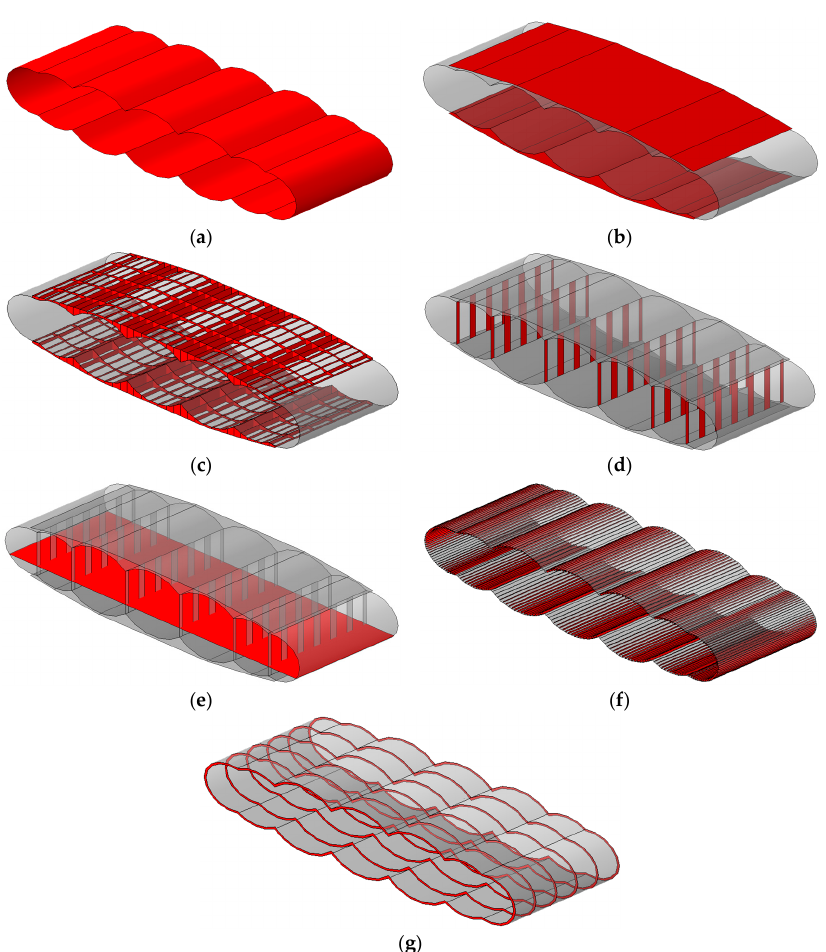
Figure 3. Structural components of the multi-bubble fuselage comprising of ( a ) generated 3D cabin skin, ( b ) separate outer skin, ( c ) cross ribbed design for the inner and outer skin, ( d ) interrupted walls, ( e ) floor connected to walls and cabin skin and ( f ) stringers in the curved cabin skin. Here, ( g ) represents the division of the fuselage in the chord wise direction.